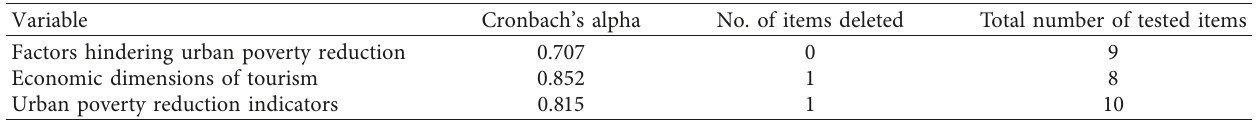
Table 1: Reliability analysis.